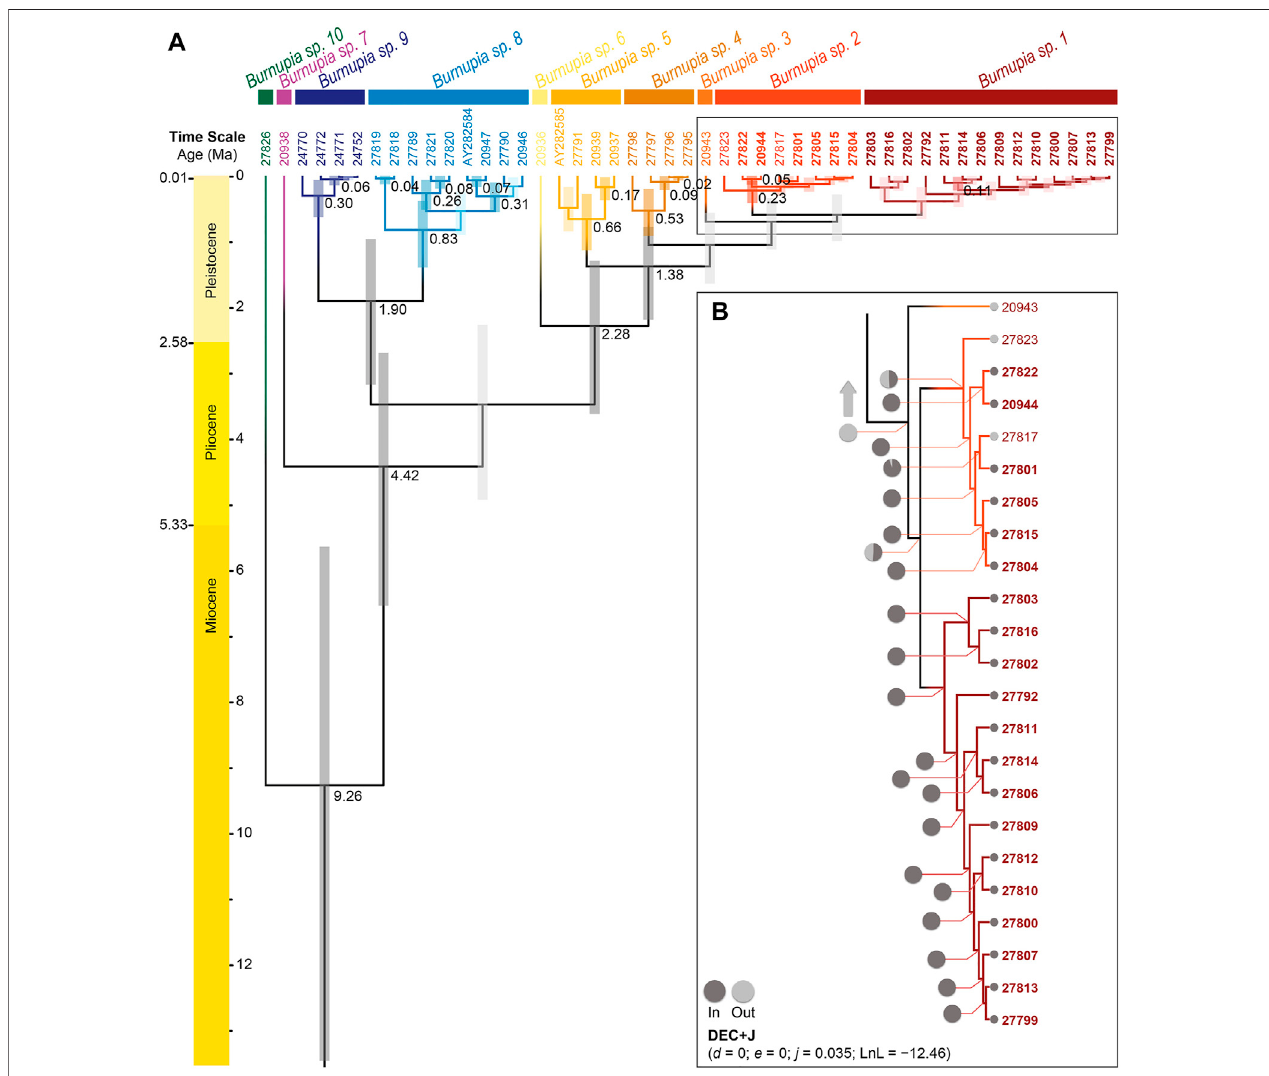
FIGURE 4 | (A) The dated phylogeny of Burnupia spp. sampled across southern and eastern Africa constructed in BEAST based on COI sequence data. Supporteddivergence events (PP ≥ 0.95) areindicatedbywrittendatesat thenodes (in millions ofyears ago;Ma) and brighter shaded 95%credibility interval (i.e.,HPD) bars. Species or clades are partitioned and coloured according to the DAPC species delimitation results (see Figure 2 ). Tip labels correspond to the preparation numbers of specimens noted in Table 1 and, therein, those in bold correspond to specimens occurring in the Lesotho Highlands. (B) The portion of the DEC+J results of the ancestral area estimation for Burnupia spp. on the dated phylogeny that correspond to Lesotho Highland occurrences. Ancestral area estimations were obtained from BioGeoBEARS run through RASP. Nodal pie charts represent the relative likelihood of the lineage occurring within the Lesotho Highlands (dark grey) and outside of the Lesotho Highlands (light grey). Smaller pies at the tips represent the current occurrence ofeach specimen. All other nodes across the phylogeny (data not shown; indicated by the light grey arrow) are equivalent to ancestral areas outside of the Lesotho Highlands.